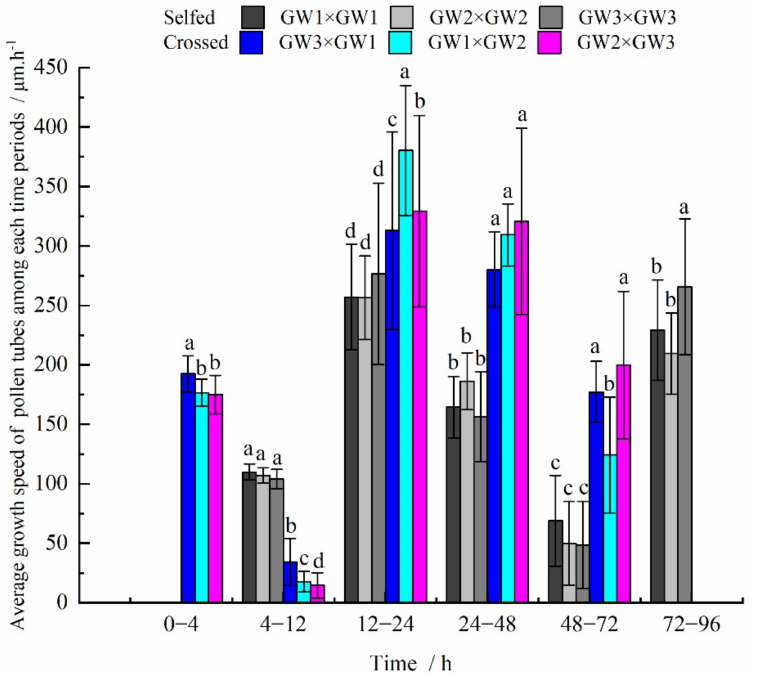
Figure 5. The average growth speed of the selfed and crossed pollen tubes within different time periods. A different letter indicates a significant difference at the level of 0.05 between different treatment